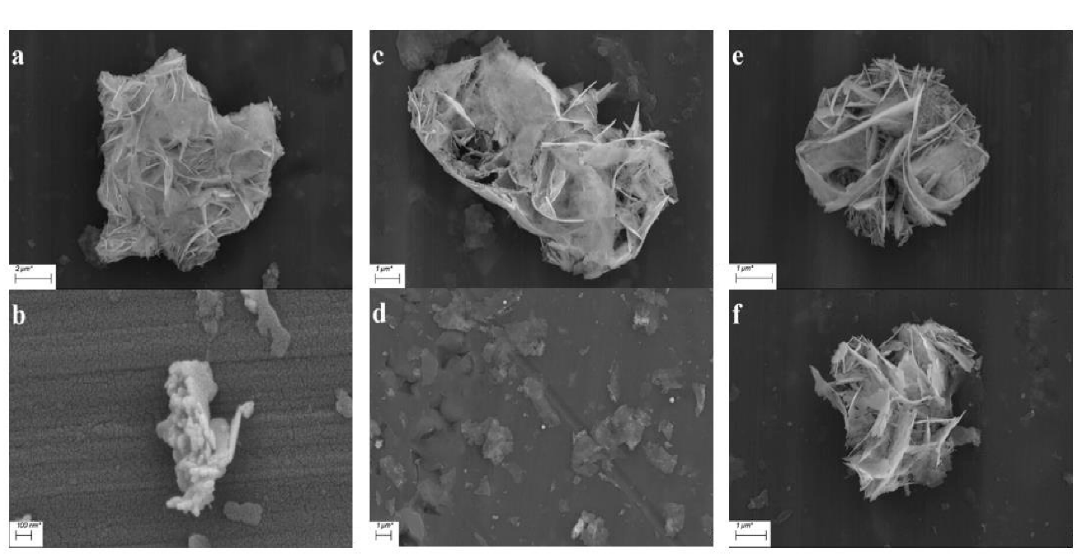
Figure 2. SEM images of BOC ( a ), BOC-CQD-5 ( b ), BOC-CQD-10 ( c , d ), BOC-CQD-15 ( e ) and BOC-CQD-20 ( f ).